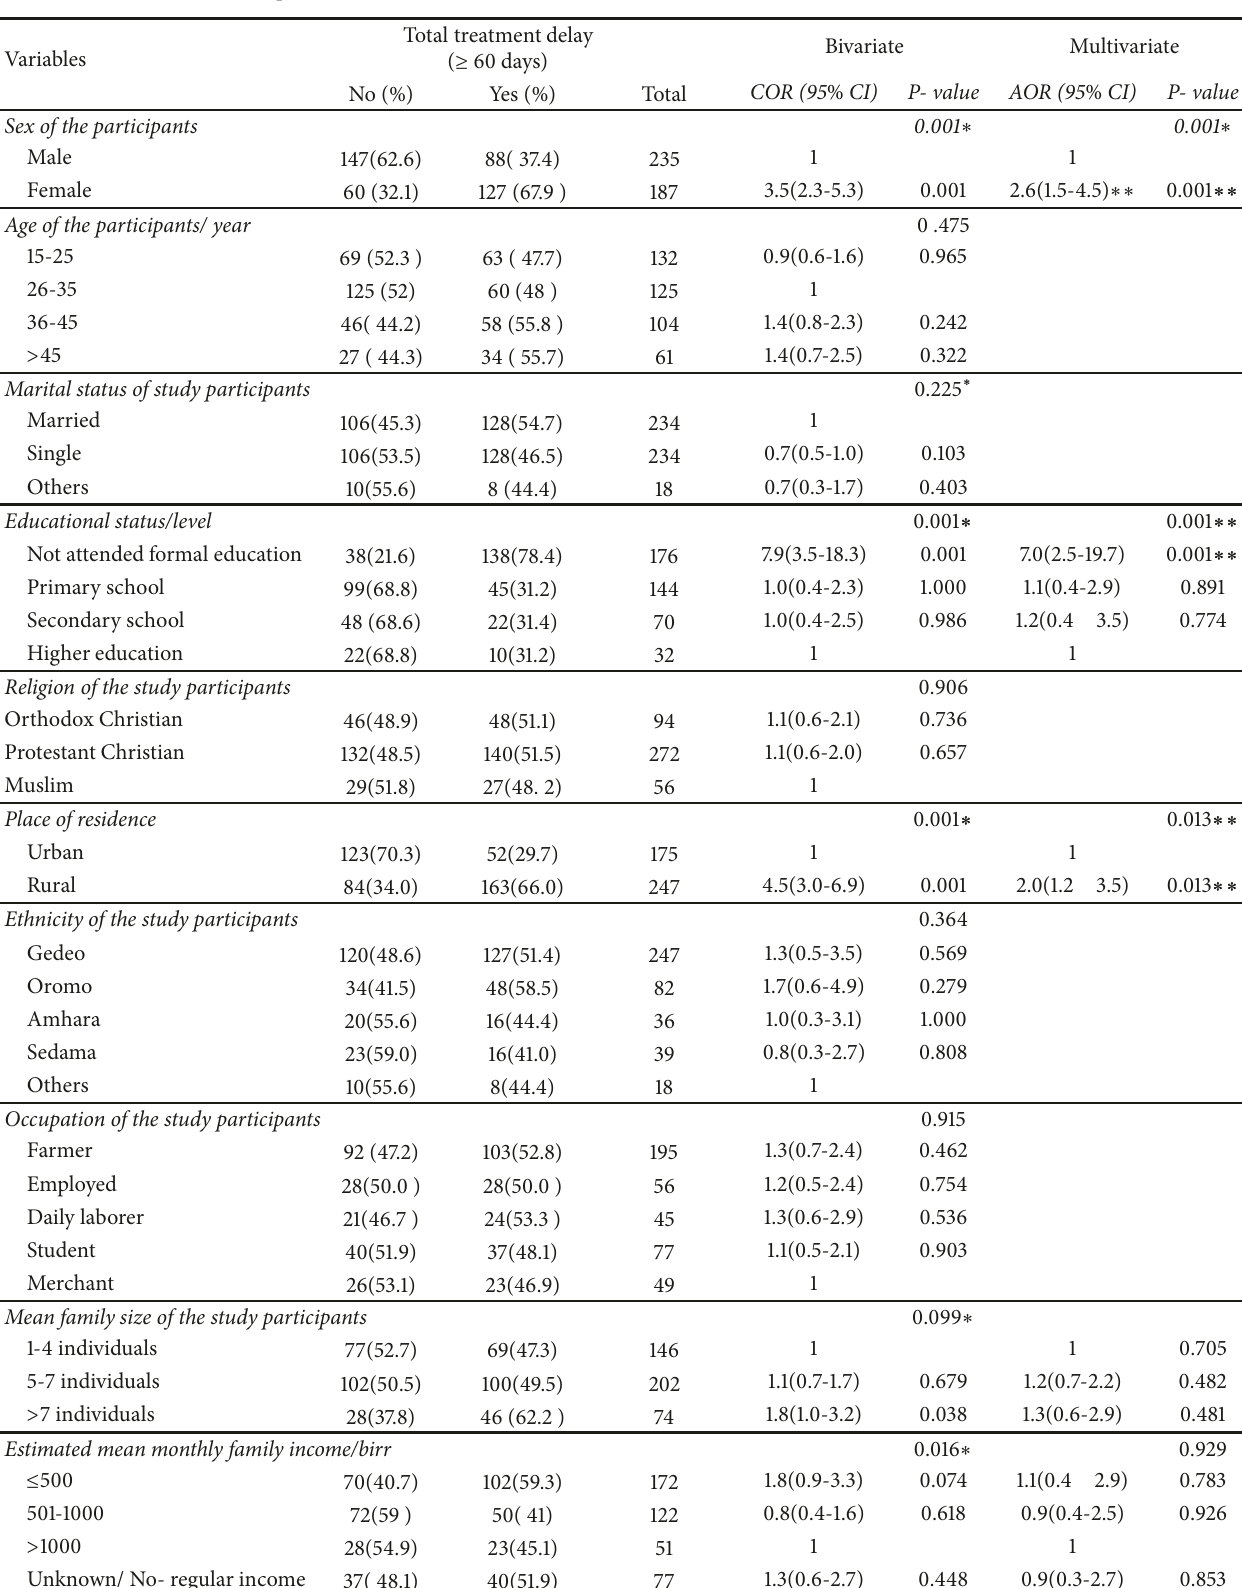
Table 9: Bivariate and multivariateanalysis of associatedfactorsfor total treatmentdelay among study participants of selectedhealth facilities of Gedeo Zone, southern Ethiopia,